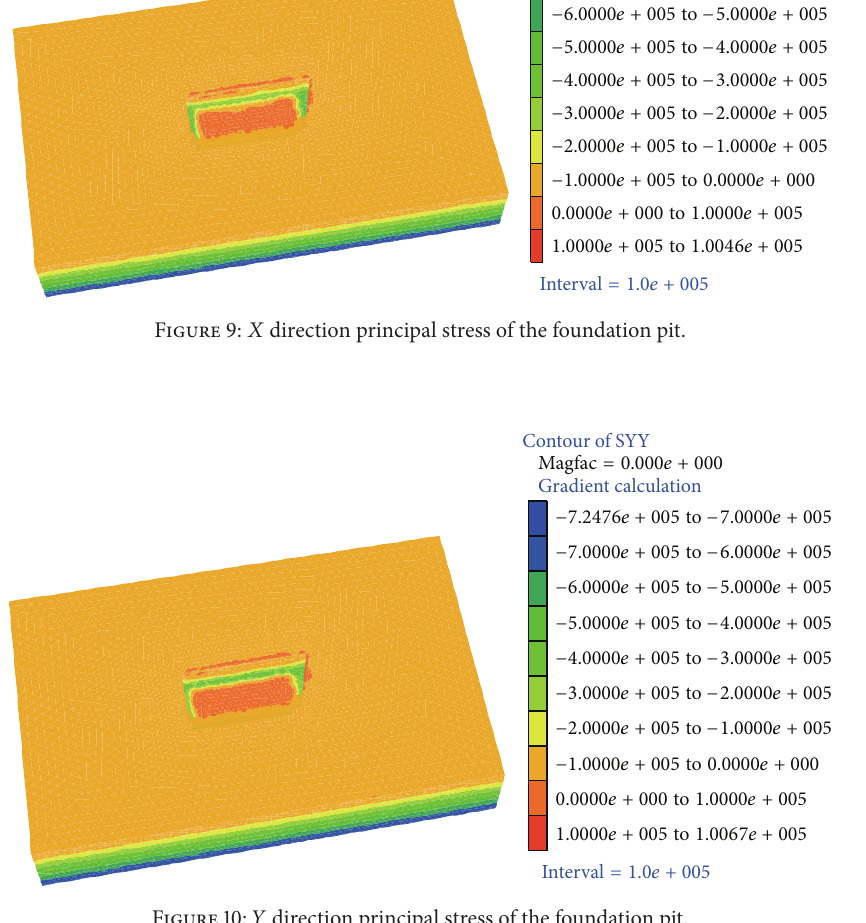
Figure 10: 𝑌 direction principal stress of the foundation pit.